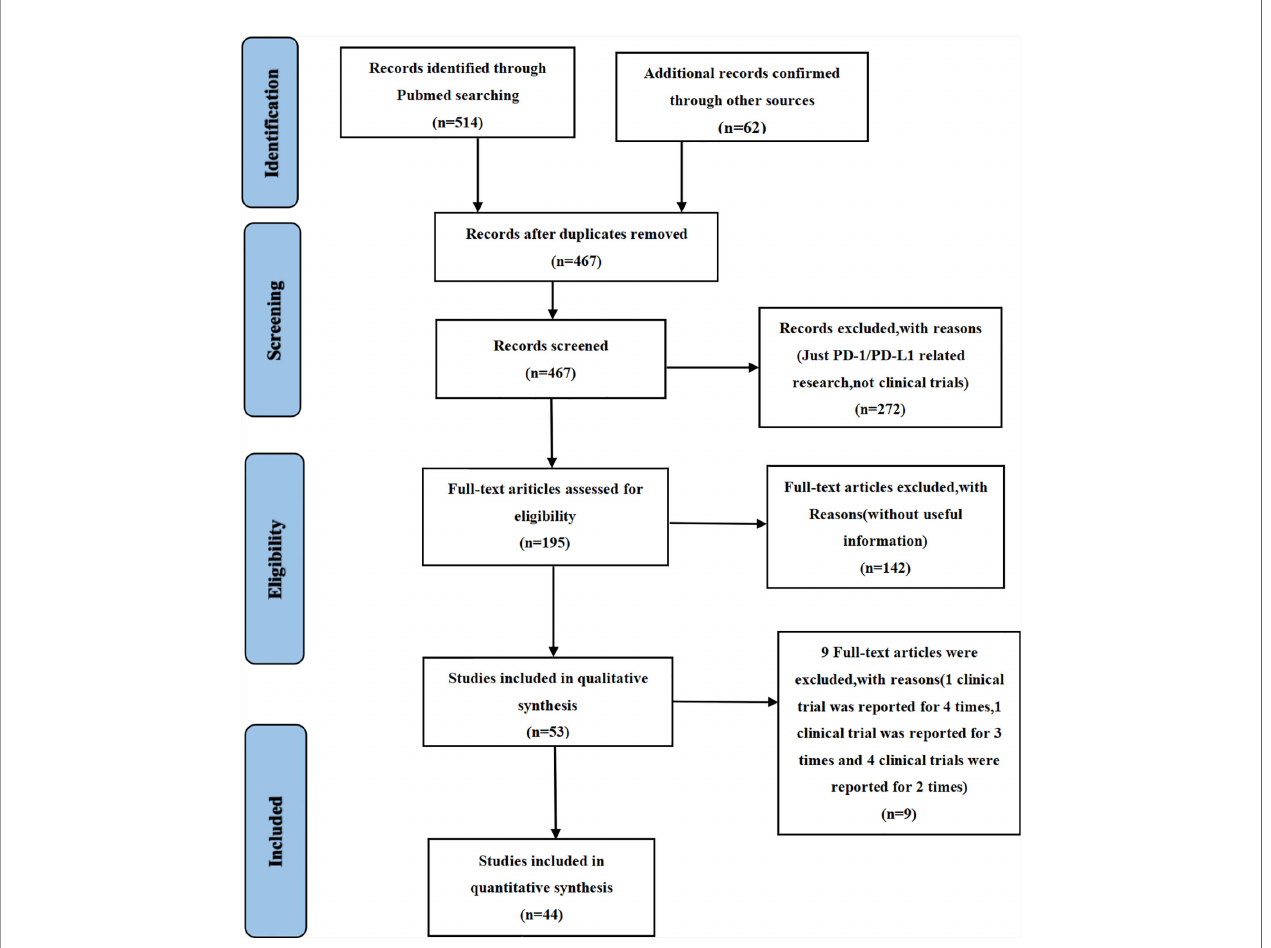
FIGURE 1 | The fl ow diagram of enrolled clinical